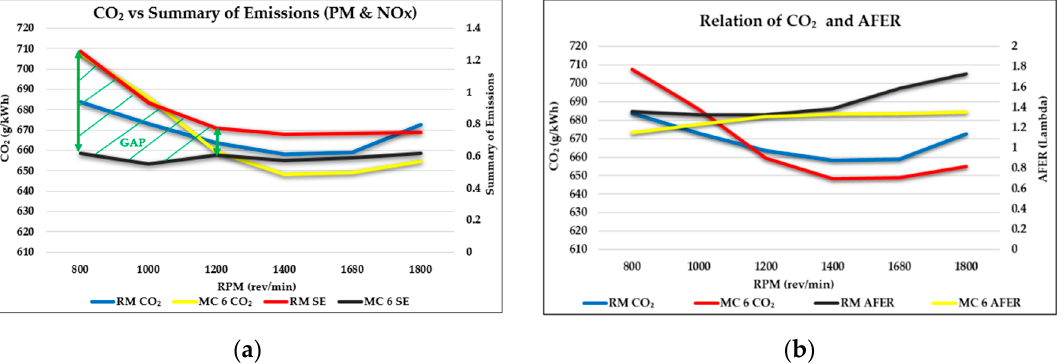
Figure 6. Relation of CO ₂ , summary of emissions and air-fuel equivalence ratio (AFER) for RM and MC 6. ( a ) CO 2 (g/kWh) vs. summary of emissions (PM and NOx) and ( b ) relation of CO 2 (g/kWh) and AFER.